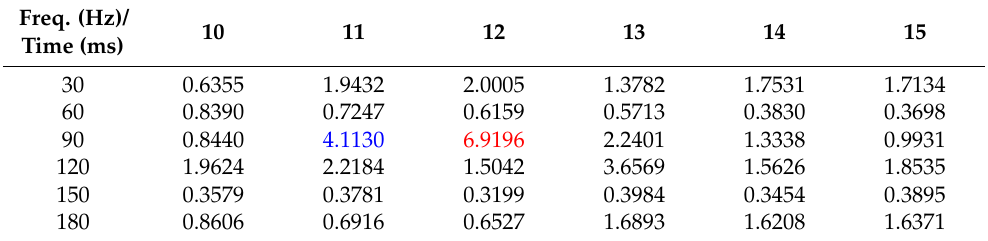
Table 9. The data of HS2 of class II, main frequency band 10–15 Hz, sampling time interval 30 ms. The maximum and second-highest energy ratios are highlighted in red and blue,